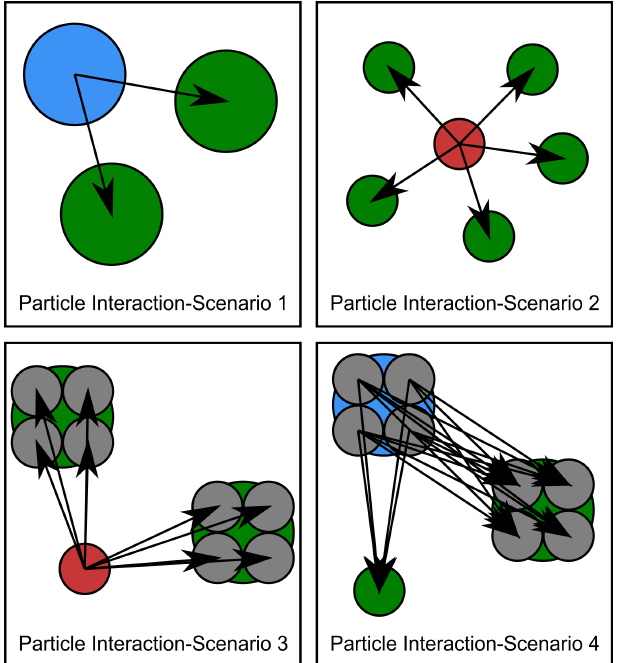
Figure 3. The particle interaction mechanism in each of the four scenarios. Small and large reference particles are shown in red and blue colors, respectively. Neighboring particles are shown in